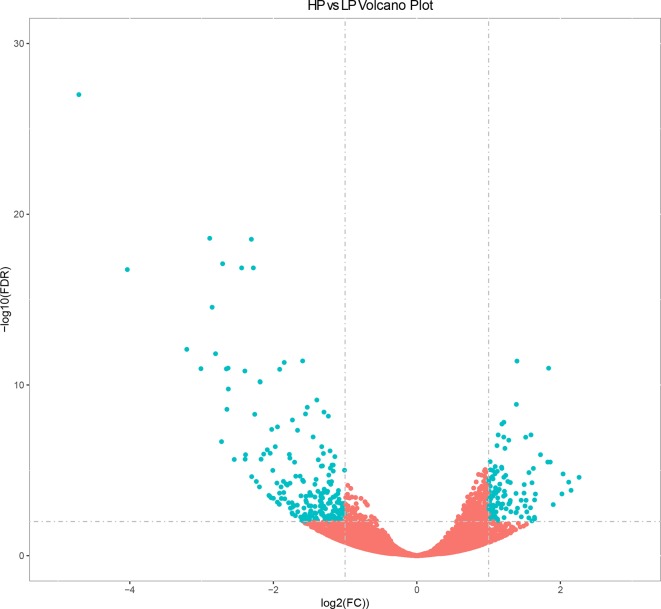
Volcano plot displaying differential expressed genes in bovine liver tissues with transcriptomic analyses within two different comparison groups. The y axis corresponds to the mean expression value of log10 (q value), and the x axis displays the log2 fold change value. The blue dots represent the significantly differential expressed transcripts; the red dots represent the transcripts whose expression levels did not reach statistical significance.